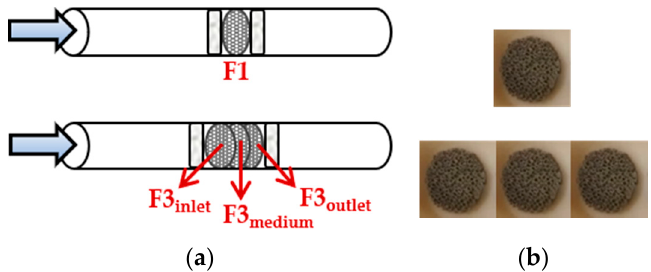
Figure 6. ( a ) Scheme of reactor loading in a single and triple catalytic bed ( b ) and images of single and triple portion of the structured catalyst Ni-SmDC/NiCrAl, named as F1 (above) and F3 (below). The effect of GHSV and reaction temperature on the catalytic activity of F1 and F3 are discussed.